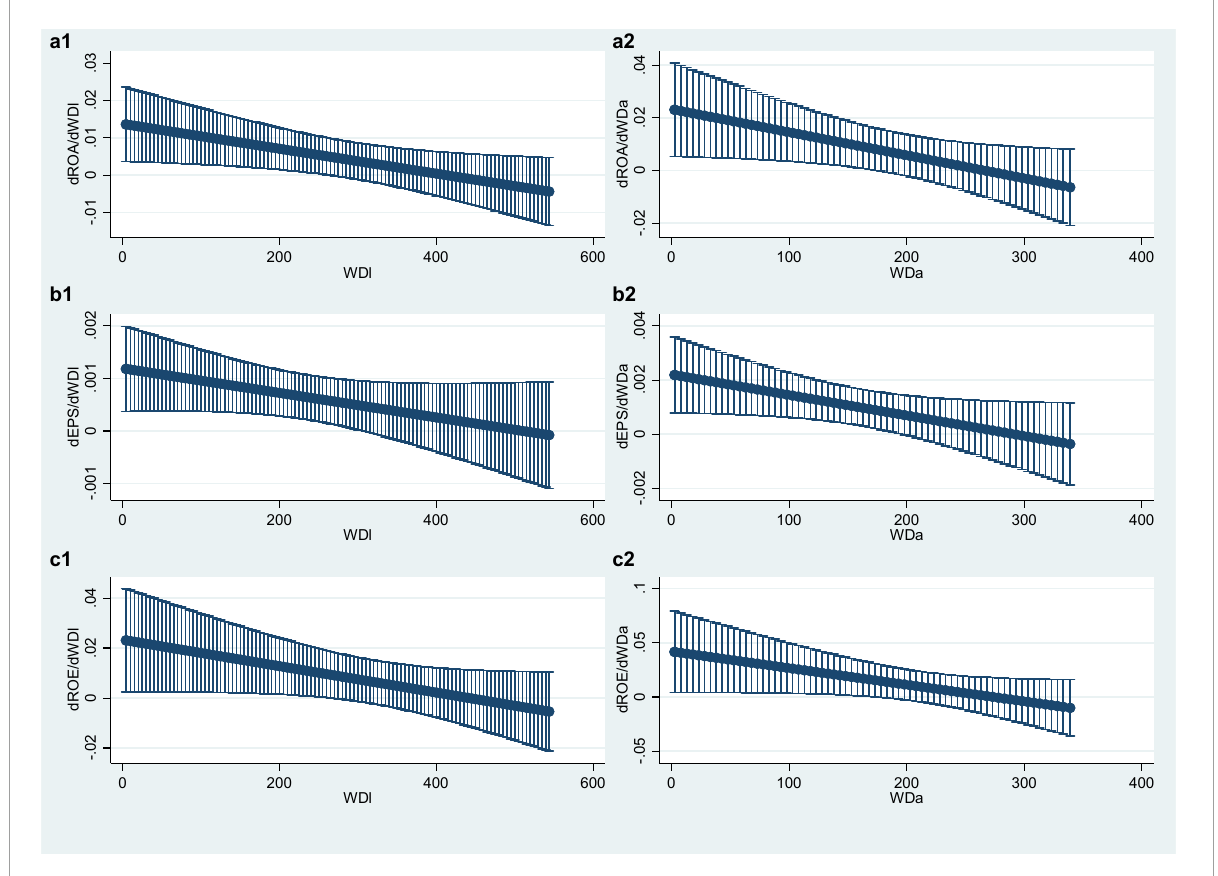
FIGURE2 Marginal contribution of WD. (a1–c2) Represent the relationship between different variables.